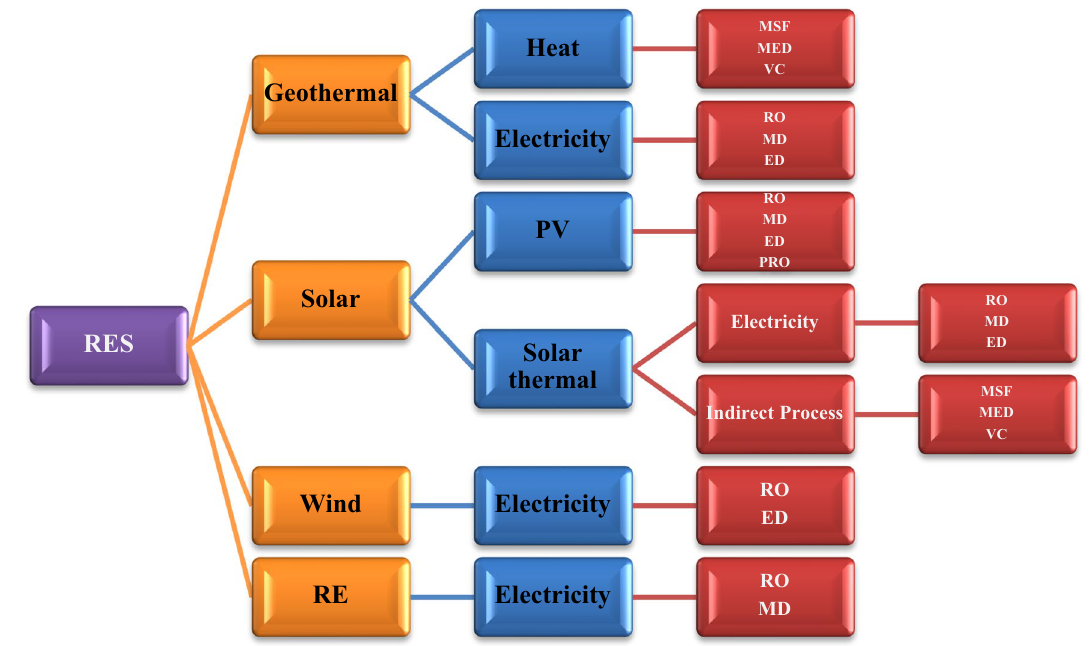
Fig. 21 Chart of combining different desalination methods with renewable energy resources. PV photovoltaic, RES renewable energy source, RE reverse electrodialysis, RO reverse osmosis, MD mem-